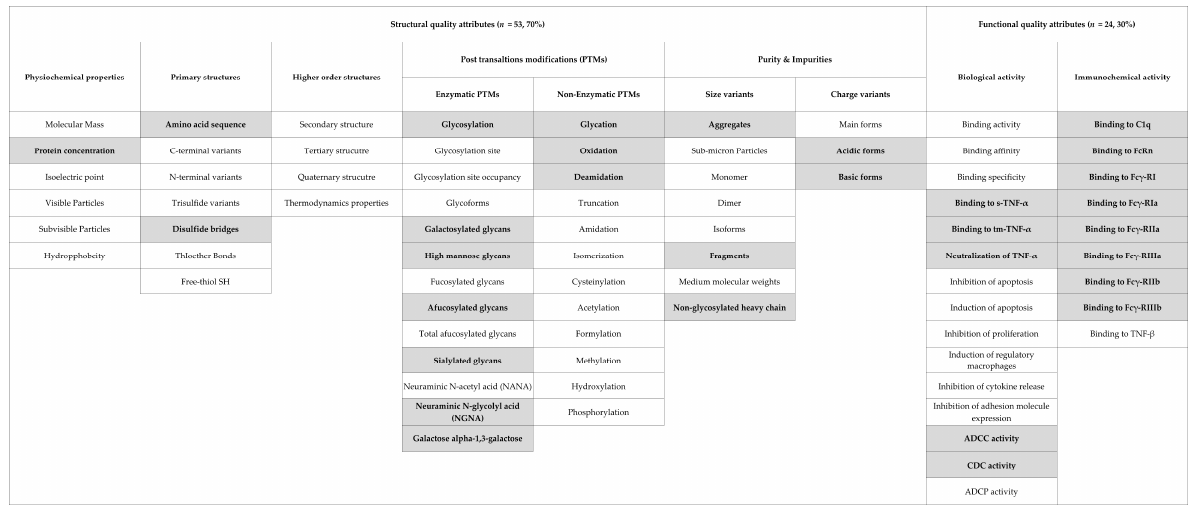
Figure 2. Classification scheme for 77 common quality attributes (QAs) of biologicals including 31 potentially critical quality attributes (pCQAs) relevant to adalimumab. The pCQAs are presented in gray boxes. Definitions: ADCC: antibody-dependent cellular cytotoxicity, ADCP: antibody-dependent cellular phagocytosis, CDC: complement-dependent cytotoxicity, C1q: complement component 1q, TNFα: tumor necrosis factor-alpha, s-TNFα: surface tumor necrosis factor-alpha, tm-TNFα: transmembrane tumor necrosis factor-alpha, Fc: fragment crystallizable, FcR: Fc receptor.